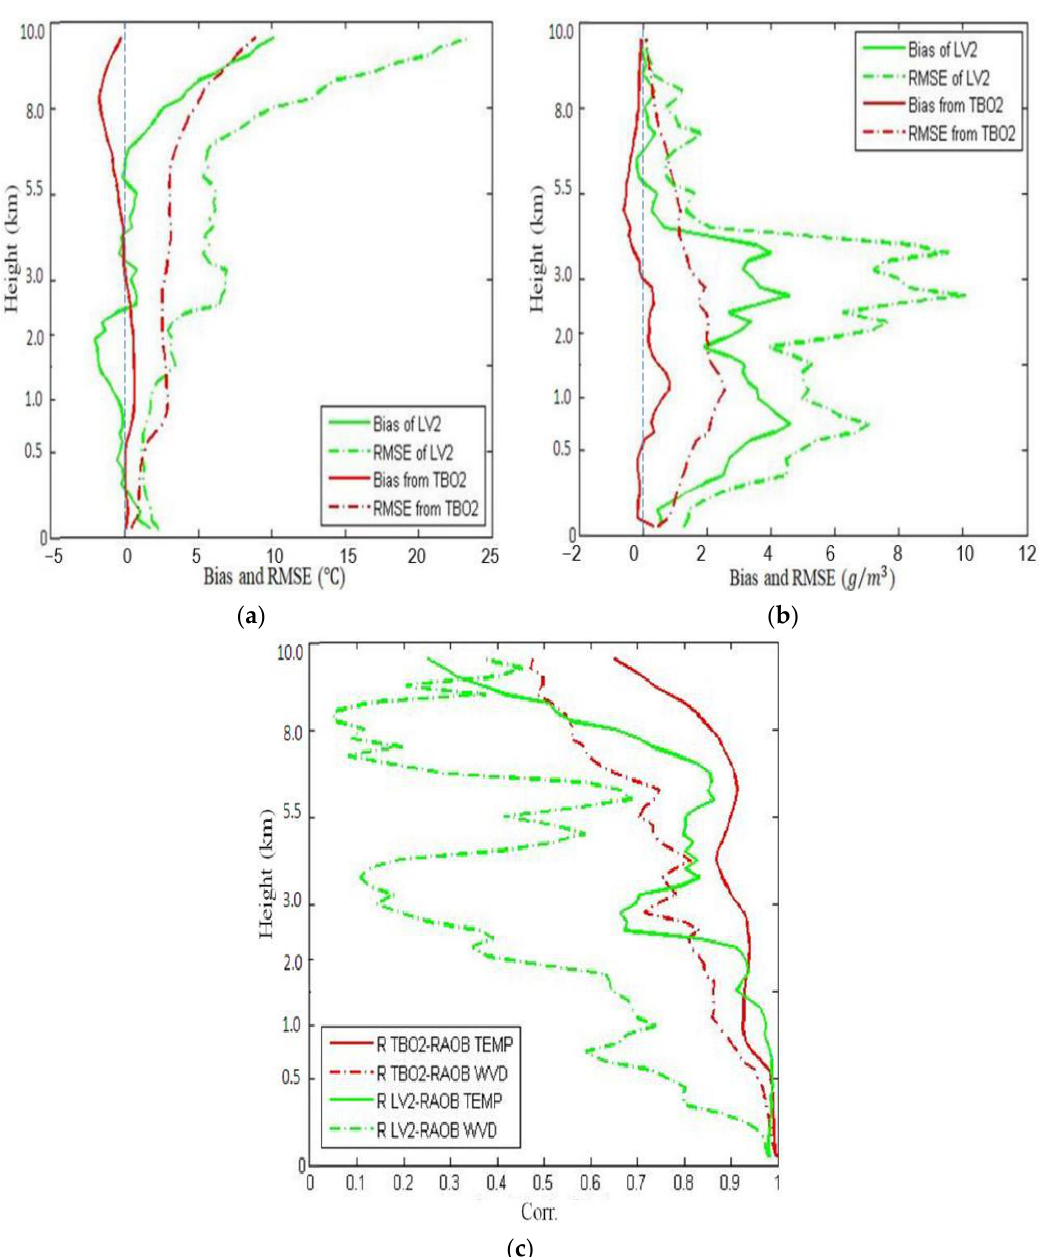
(cid:42) f − T BO 2 retrievals